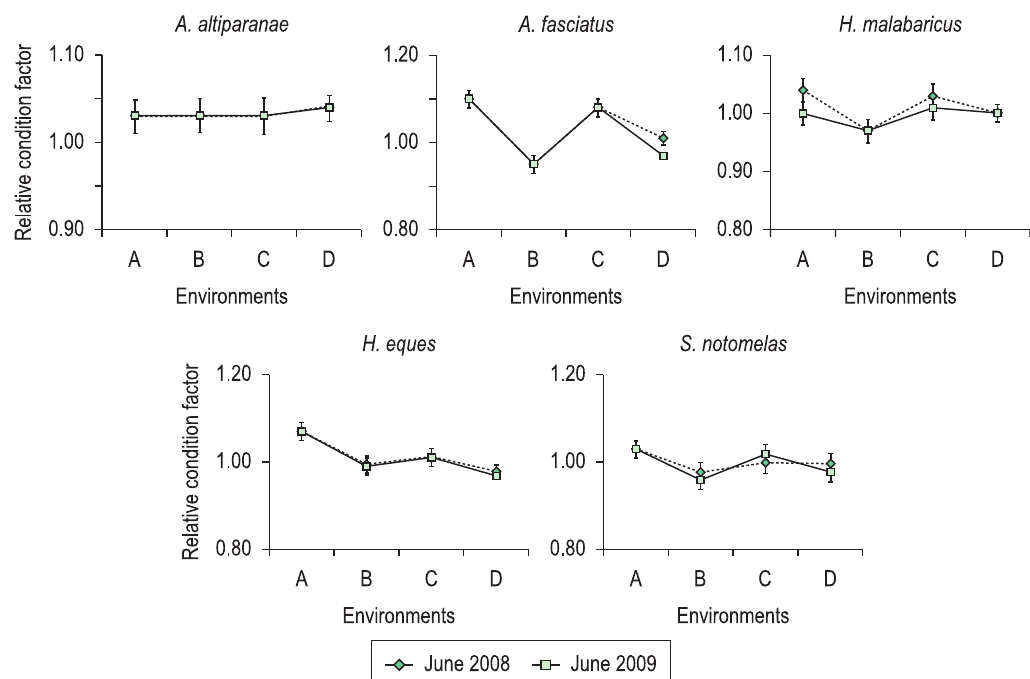
Figure 2. Comparison of the average relative condition factors (with standard error) of the five species, in each period in the four habitats: a) The reservoir of Gavião Peixoto Dam; b) Jacaré-Guaçu River; c) floodplain lake; d) Chibarro